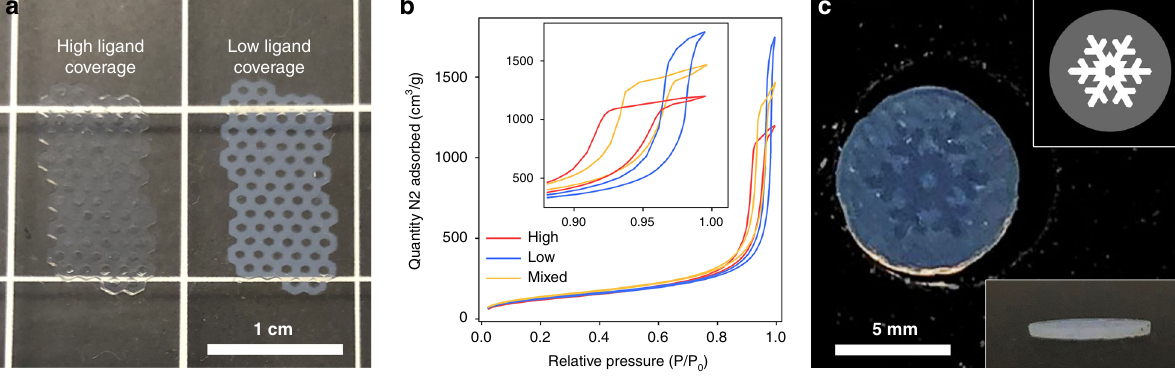
Fig. 3 Microstructure control. a Photograph of parts printed with silica cages with high (left) and low (right) methyl methacrylate surface coverage. b Nitrogen sorption isotherms of parts printed with parent high (red line) and low (blue line) methyl methacrylate coverage materials, and with mixed (yellow line) parent materials (inset: zoom in to the hysteresis range). c Photograph of a part printed with a greyscale pattern (insets: greyscale pattern (top) and side view (bottom) of the